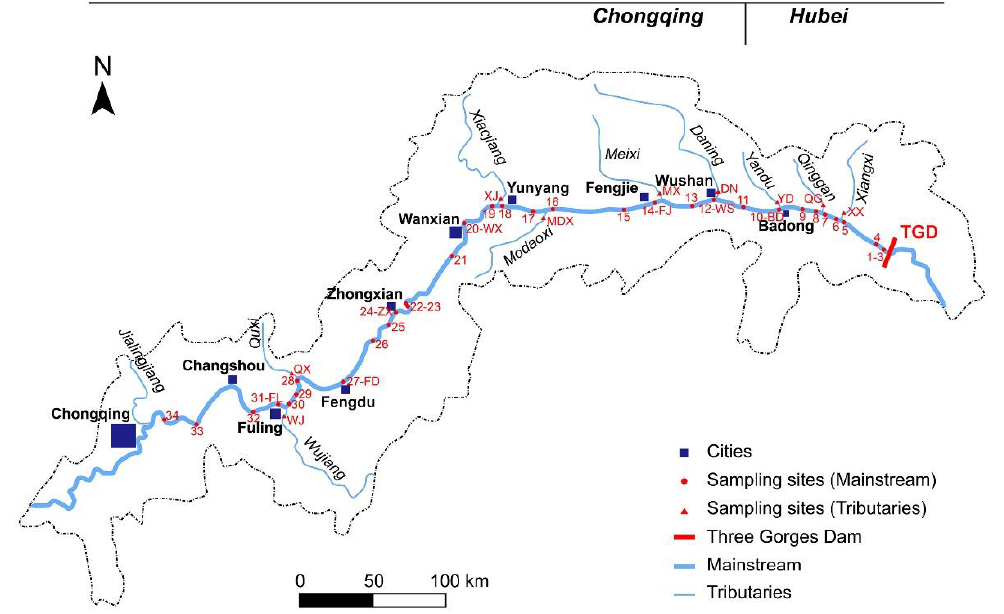
Figure 1. The study area and sampling sites in the Three Gorges Reservoir, including the sites in the mainstream and from the tributary estuaries (the size of square reflects the population of the